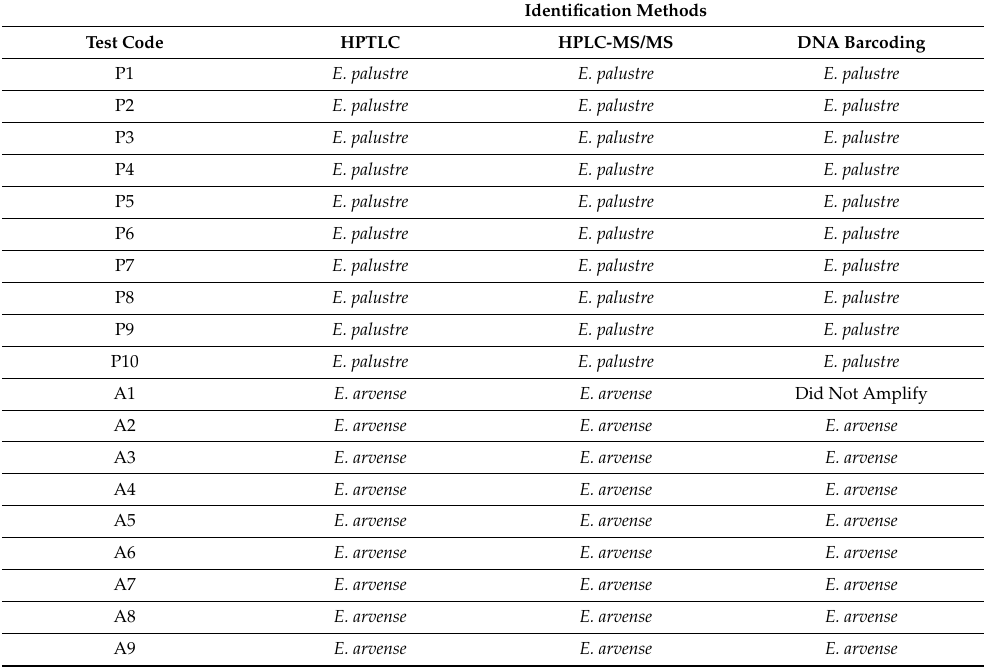
Table 4. A summary of the results gleaned from each identification method. Samples P1 and P2 were positively identified as E. palustre in every method. Sample A1 was revealed to have contamination and was not successfully identified as E. arvense with DNA. Both rbcL and ITS markers were used to conclude the identities for DNA barcoding including by cross referencing each